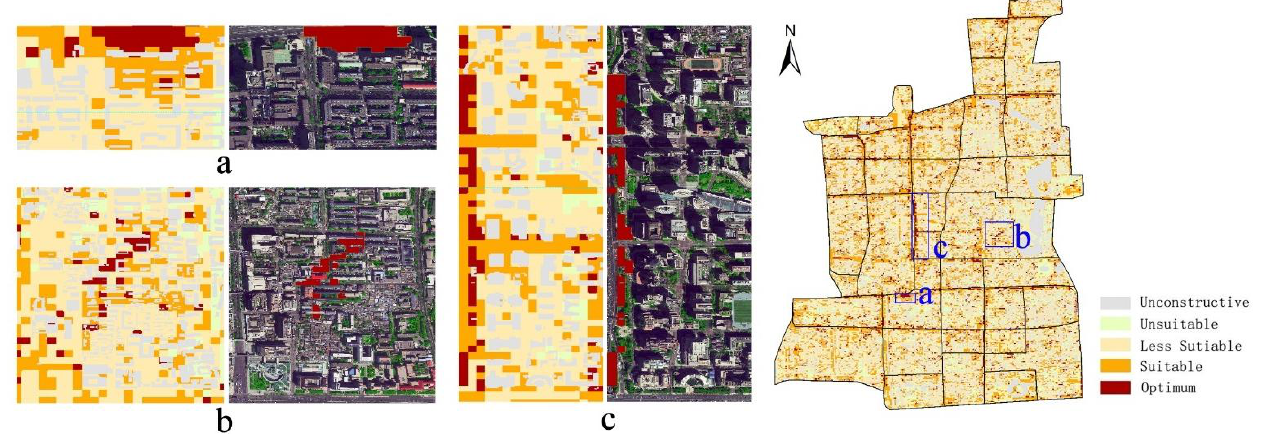
Figure 9. Correspondence between evaluation results of the location decision and the current